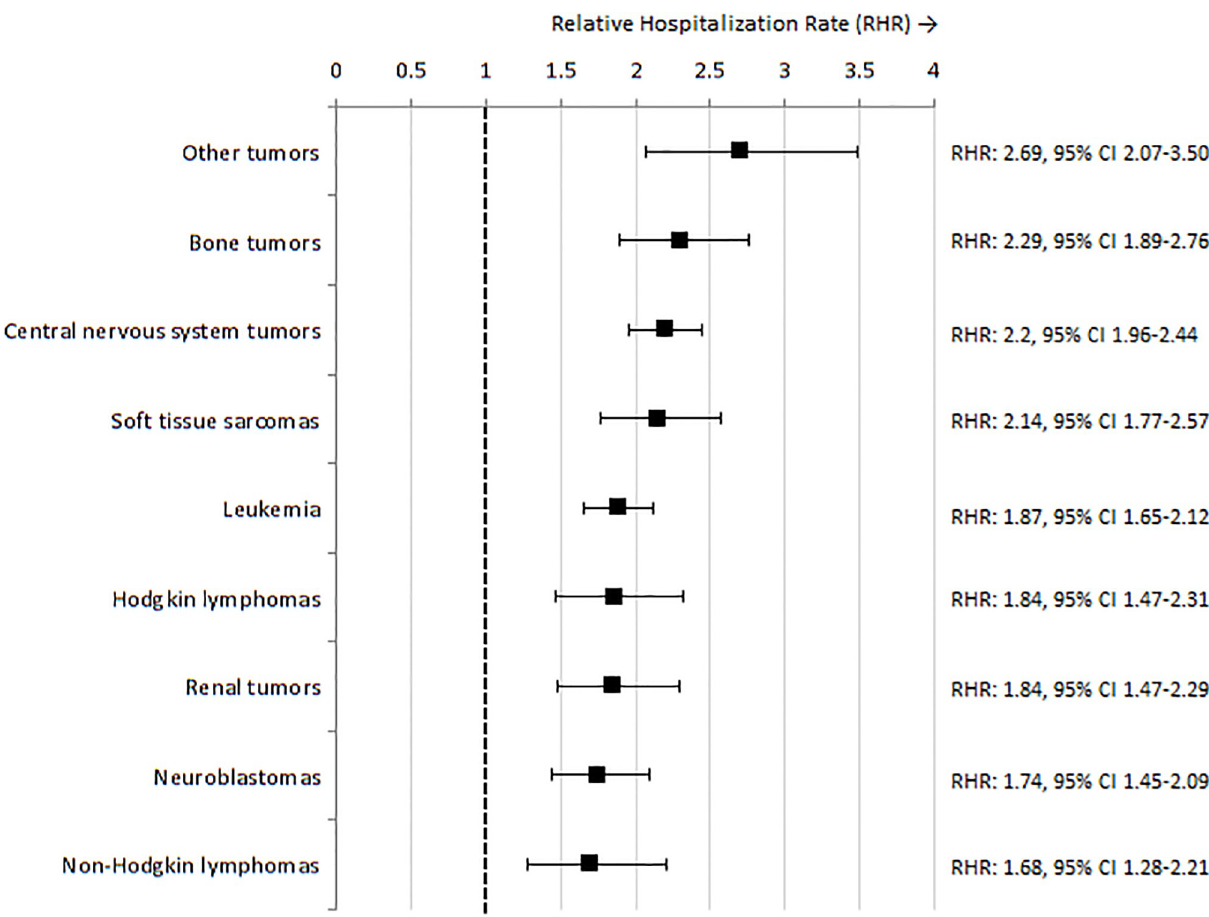
Fig 2. Relative hospitalization rates for five-year childhood cancer survivors as compared to the reference population, for by childhood cancer diagnosis.